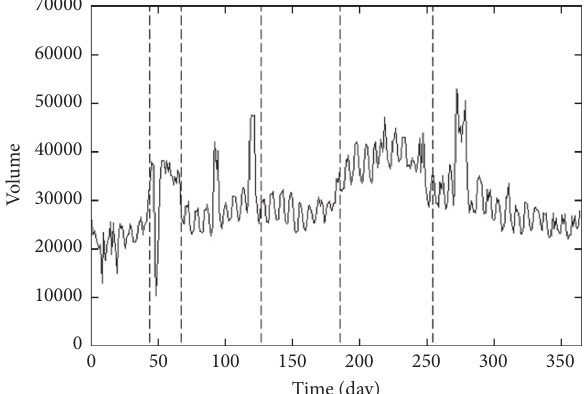
Figure 2: Description of passenger flow interval classification of high-speed